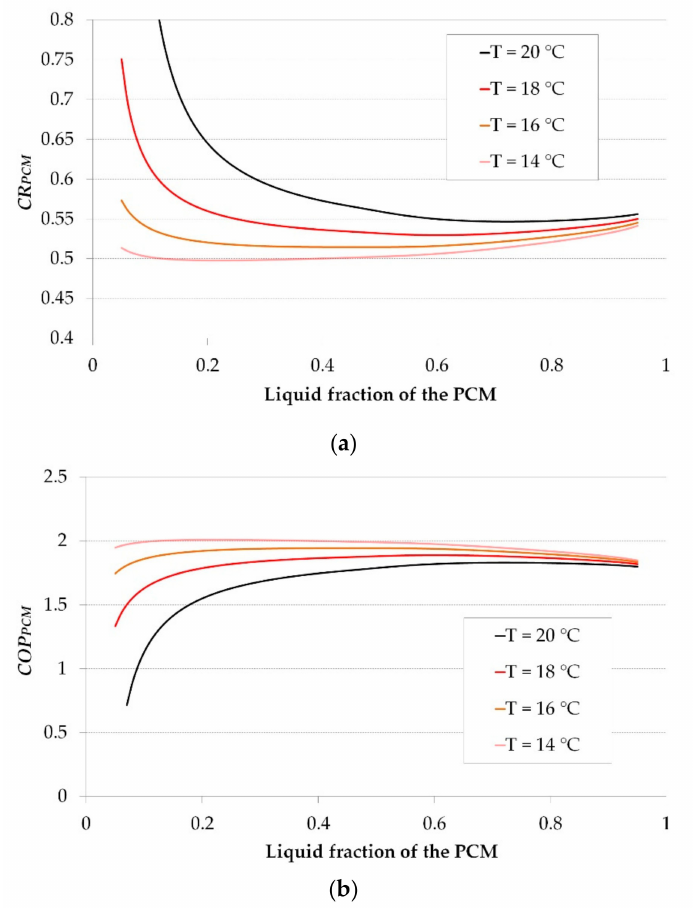
Figure 11. ( a ) CR and ( b ) coe ffi cient of performance (COP) against liquid fraction of the PCM in the PCM